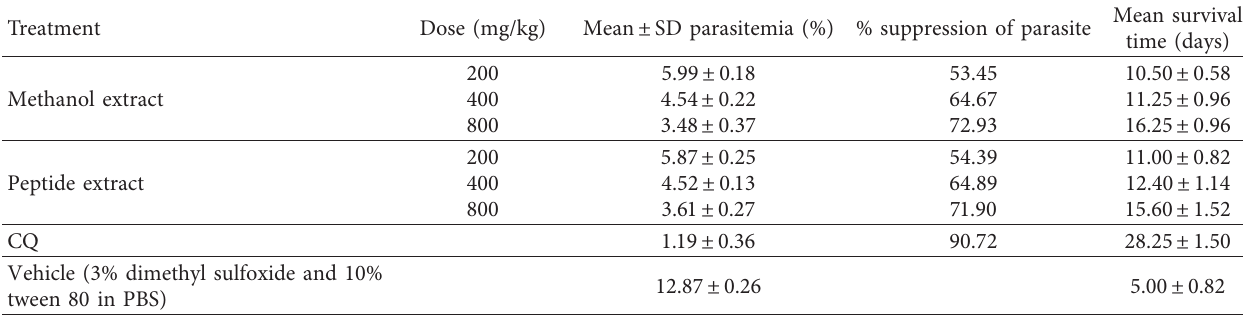
Table 4: In vivo antimalarial activities of crude extract of Glycine max in curative test on day 4 and animal survival time. Treatment